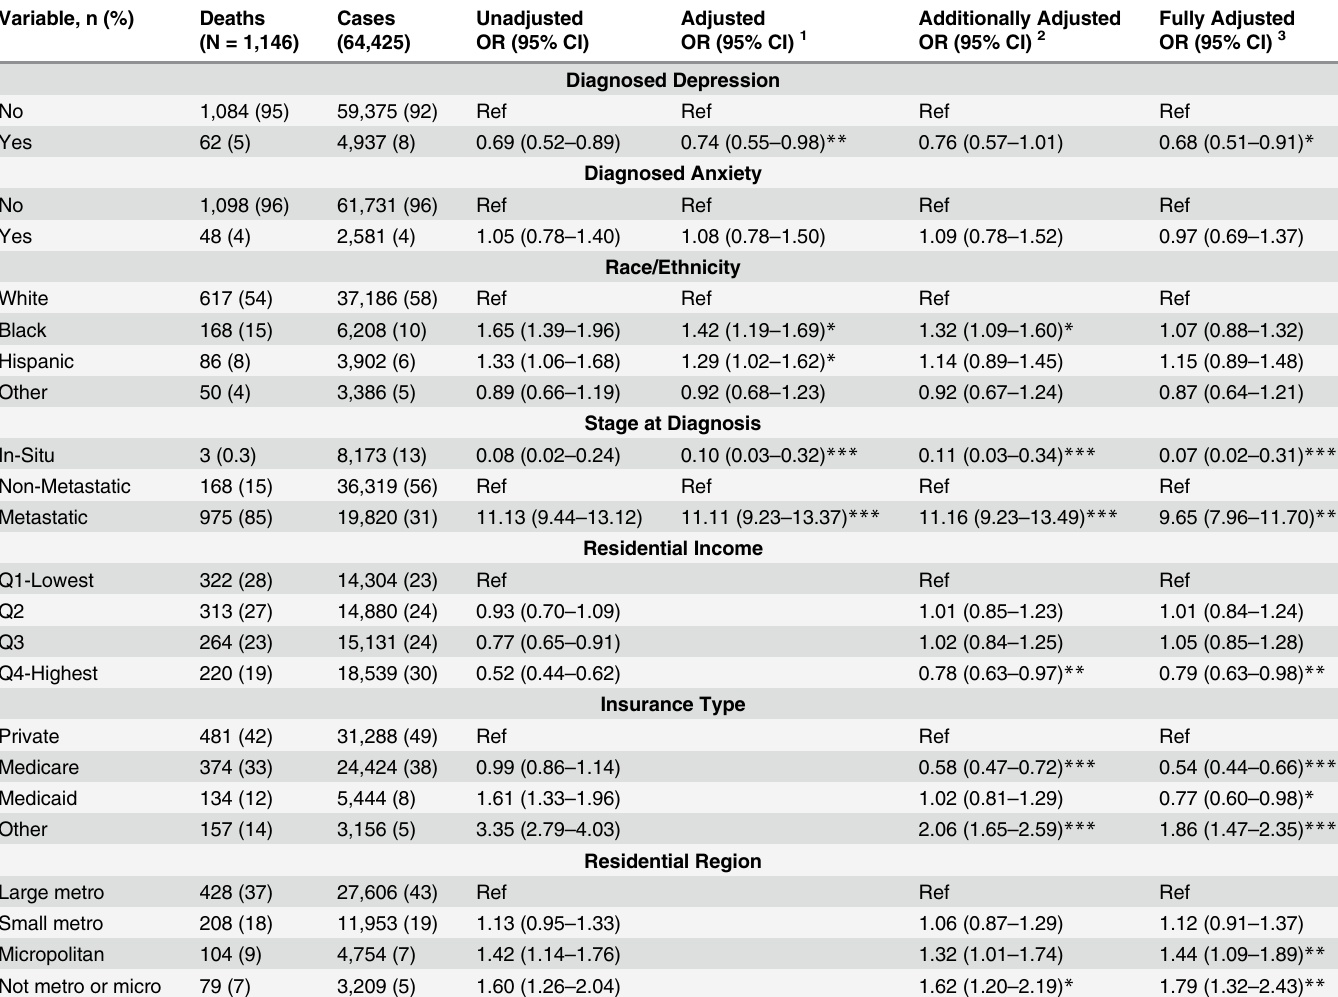
Table 3. Association between in-hospital mortality and clinically diagnosed anxiety and depression among breast cancer cases, Nationwide inpa- tient sample, 2006 – 2009 + . Variable, n